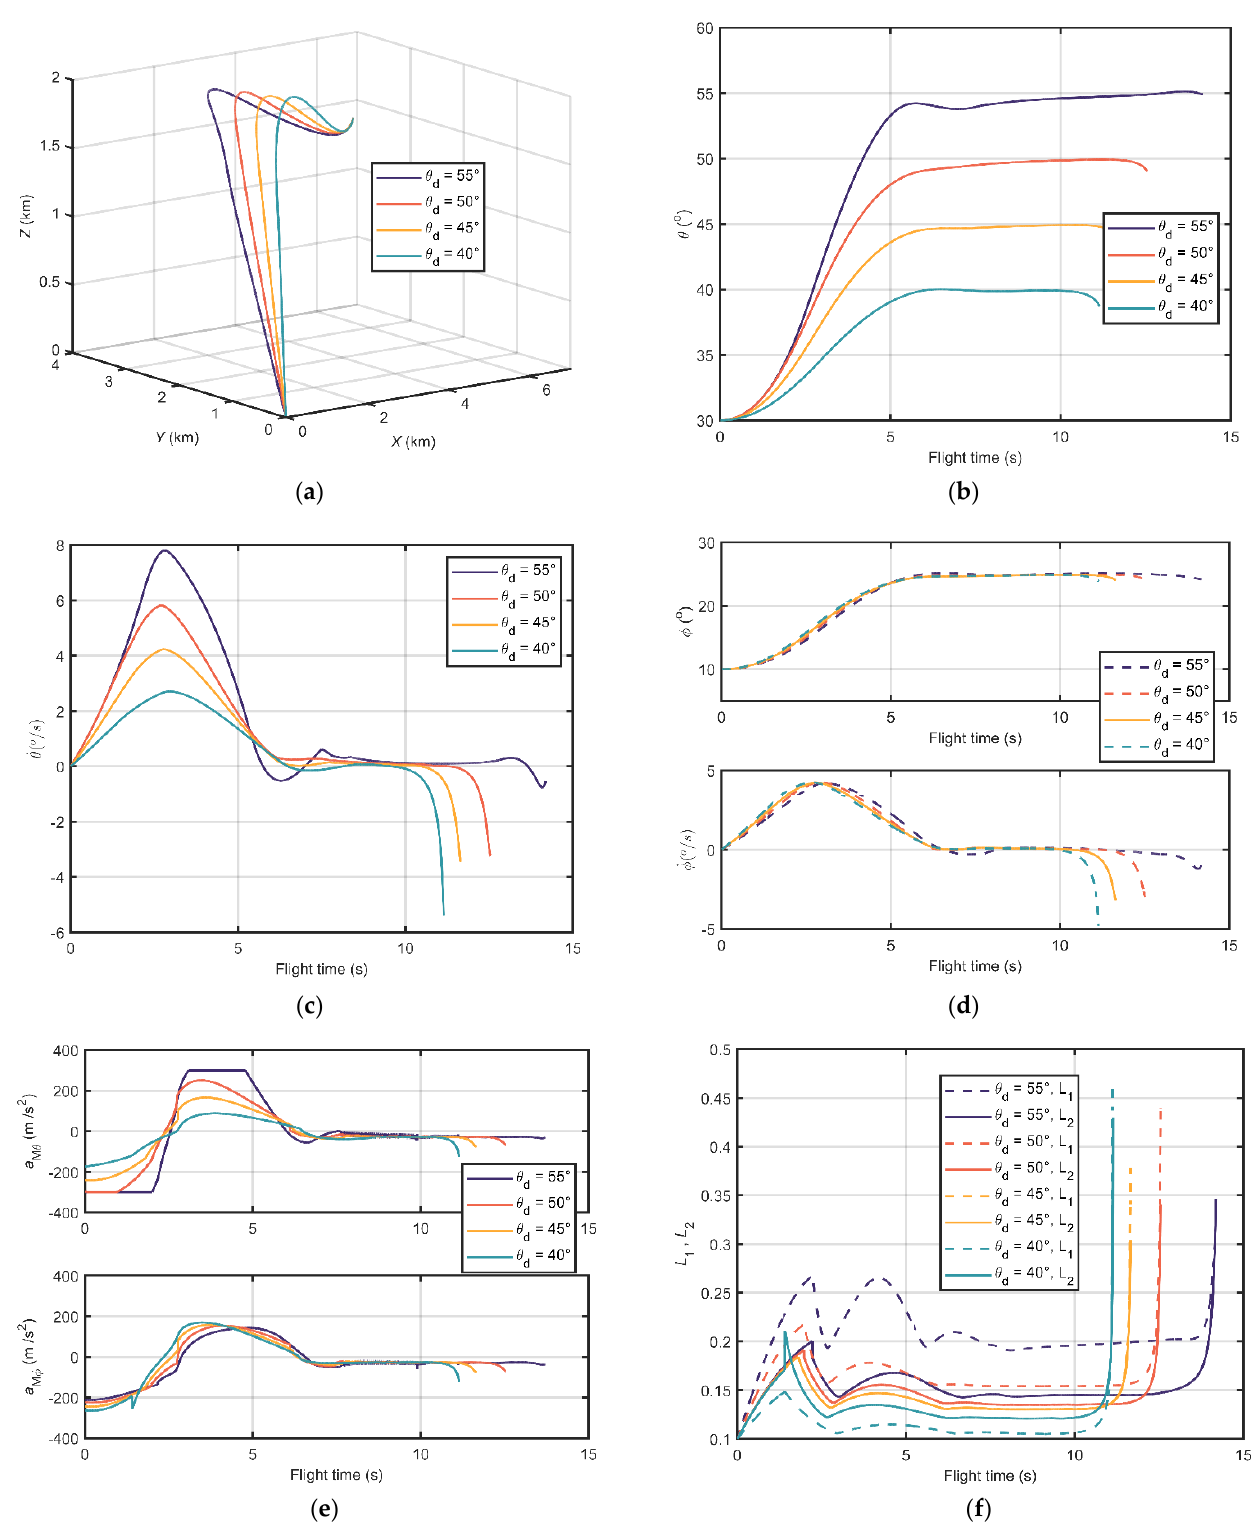
Figure 4. The simulation results under various desired terminal azimuth angles: ( a ) Relative distance trajectories between missile and target; ( b ) Azimuth angles; ( c ) Azimuth angular rates; and ( d ) Elevation angles and elevation angular rates ( e ) Output accelerations; and ( f ) The adaptive gains of the barrier function-based super-twisting guidance law.